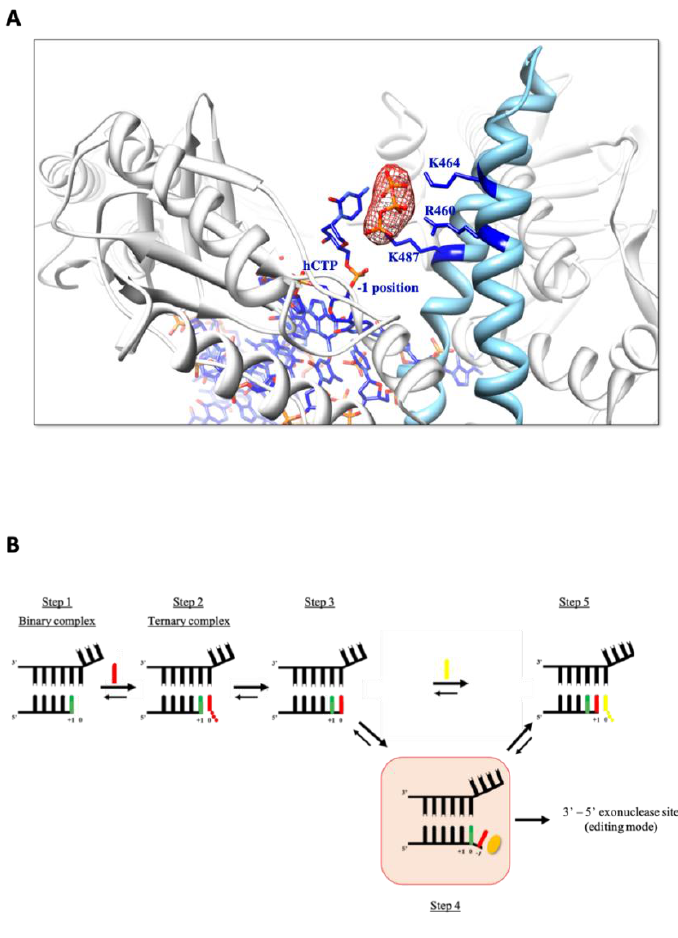
Figure 8: A possible 1 nt backtracking step in the catalytic cycle of Tgo_6G12. ( A ) X-ray structure of TgoT_6G12 in complex with a DNA substrate, which has incorporated two hCs at the 3′ end of the primer. The 2Fo – Fc -electron density map (in red) is shown around an additional triphosphate and contoured at a level of 1 σ It forms a new dNTP site inside the polymerase, called the antechamber. The triphosphate makes contacts with positively charged residues of the finger subdomain (R460, K464 and K487), represented as sticks and labeled in blue. The hC in position − 1 is labeled in blue. ( B ) Schematic view of the HNA synthesis pathway. An additional step in the catalytic cycle, step 4, is framed in red. The first incorporated hC is labeled in green and the second hC is labeled in red. The antechamber in represented by a yellow ellipse in step 4. Translocation leads to step 5 where a new incoming dNTP is represented in yellow, in position 0. Step 4 could serve as an intermediate step prior to send the fraying 3 (cid:48) end to the exonuclease site, which is inactivated in TgoT mutants studied